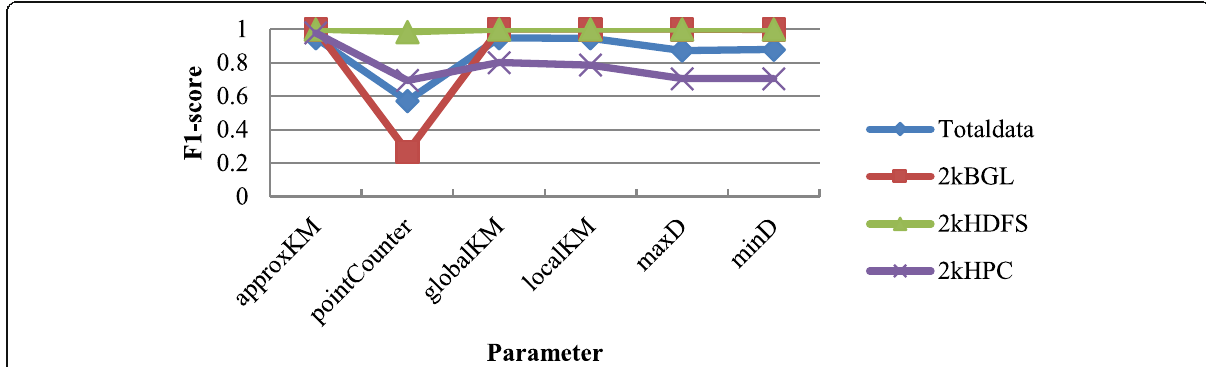
Fig. 12 F1-score corresponding to different parameters clustering on different data